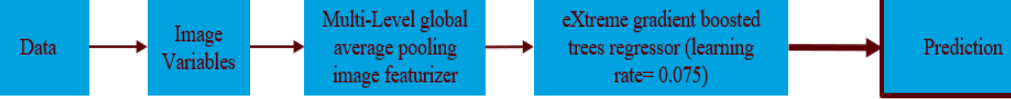
Figure 13. Supervised model workflow.